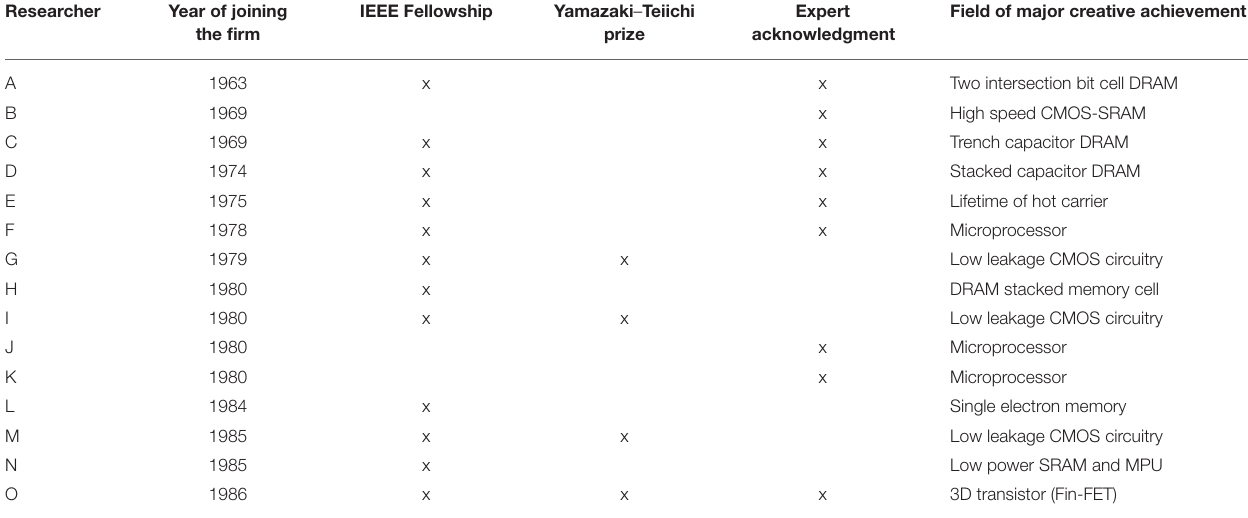
TABLE 4 | List of star researchers in the R&D department of a Japanese semiconductor company.